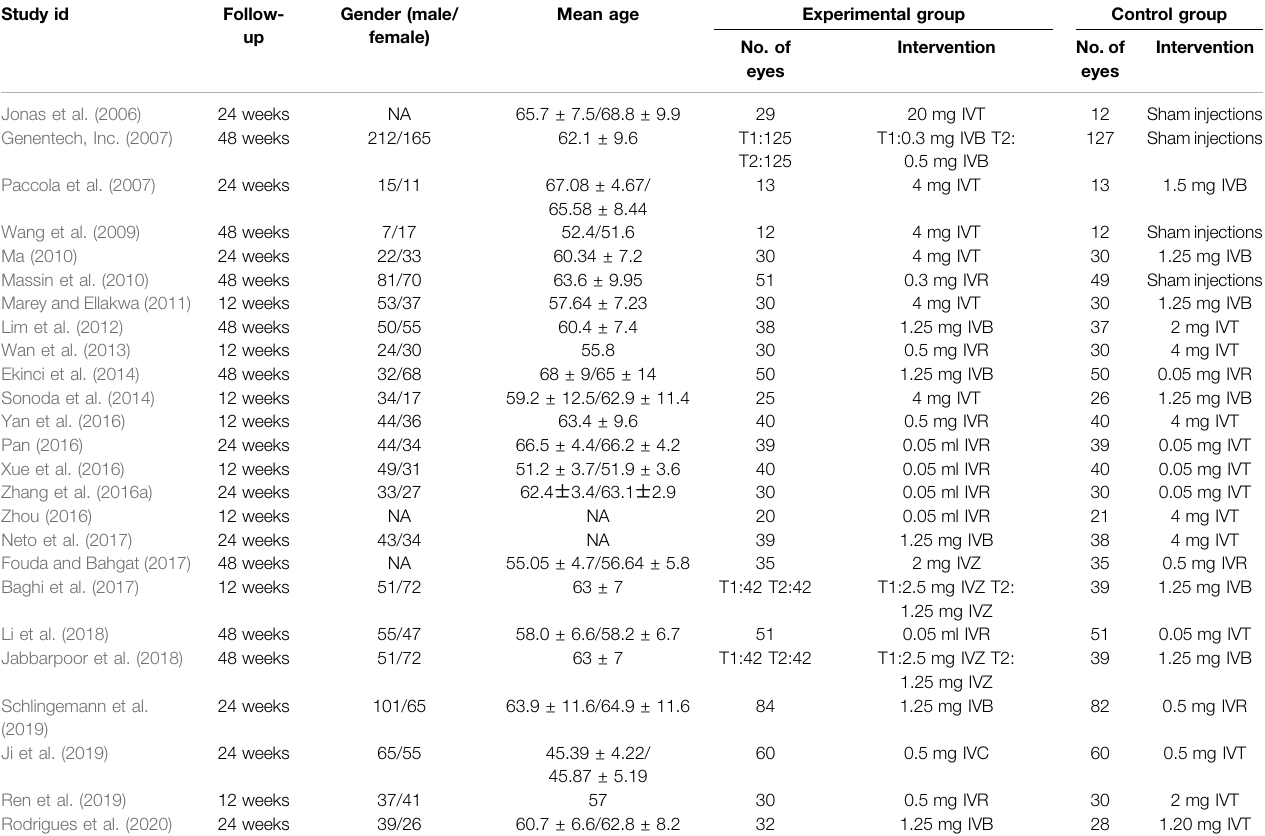
TABLE 1 | The basic characteristics of the included literature.